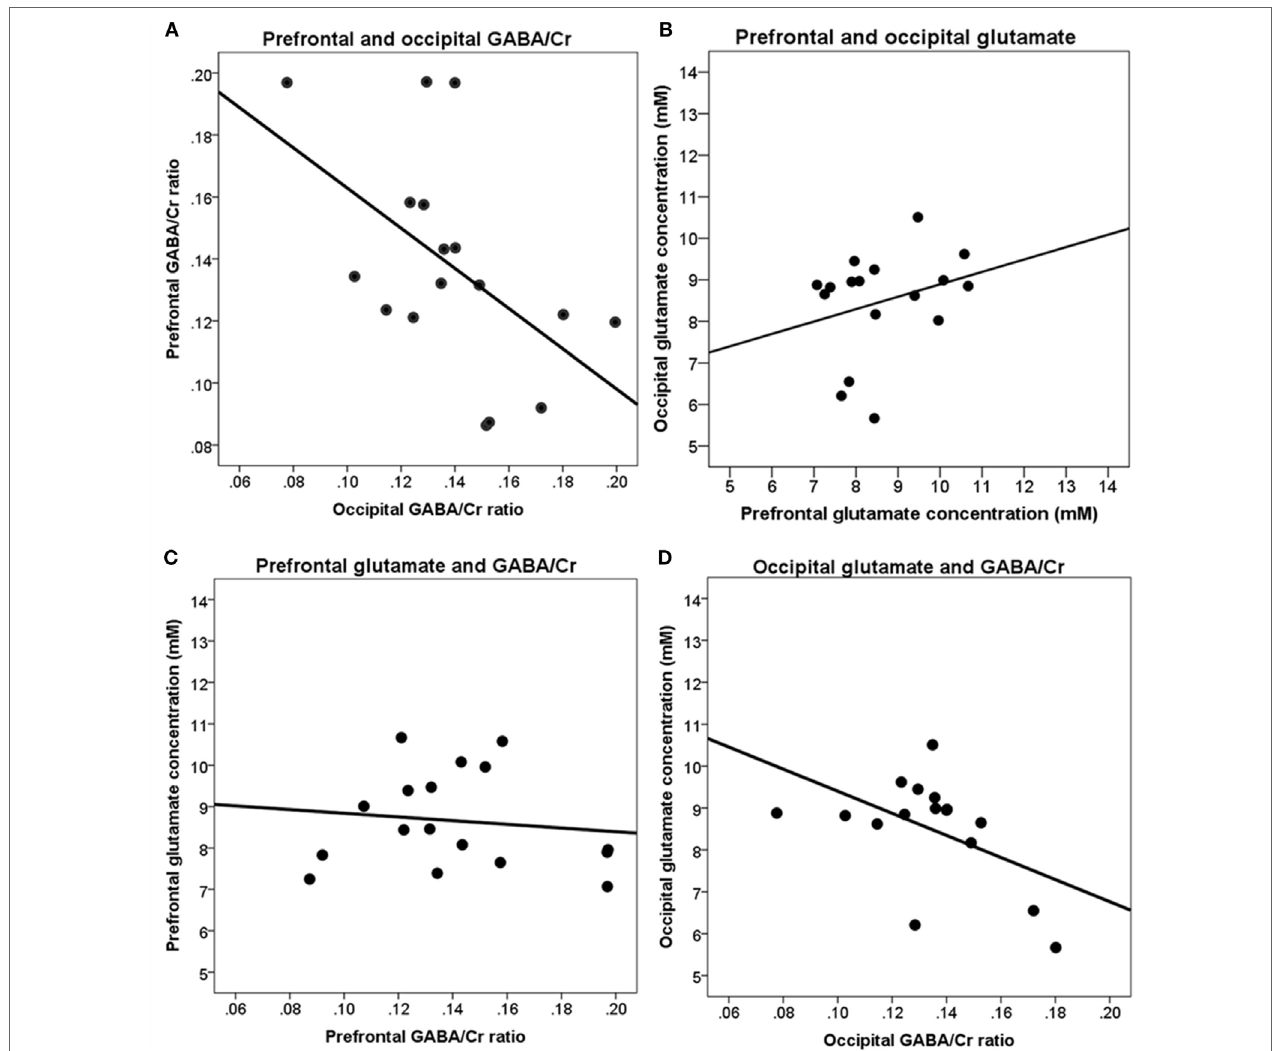
FigUre 5 | Correlations between brain metabolites in the prefrontal and occipital cortices. (a) Prefrontal and occipital GABA/Cr ratios are not significantly correlated; (B) prefrontal and occipital glutamate concentrations are not significantly correlated; (c) prefrontal GABA/Cr ratios and glutamate concentrations are not significantly correlated; (D) occipital GABA/Cr ratios and glutamate concentrations are significantly correlated [ r (7) = − 0.85, p < 0.01]. Data are presented uncorrected for gray and white matter fractions, age, and